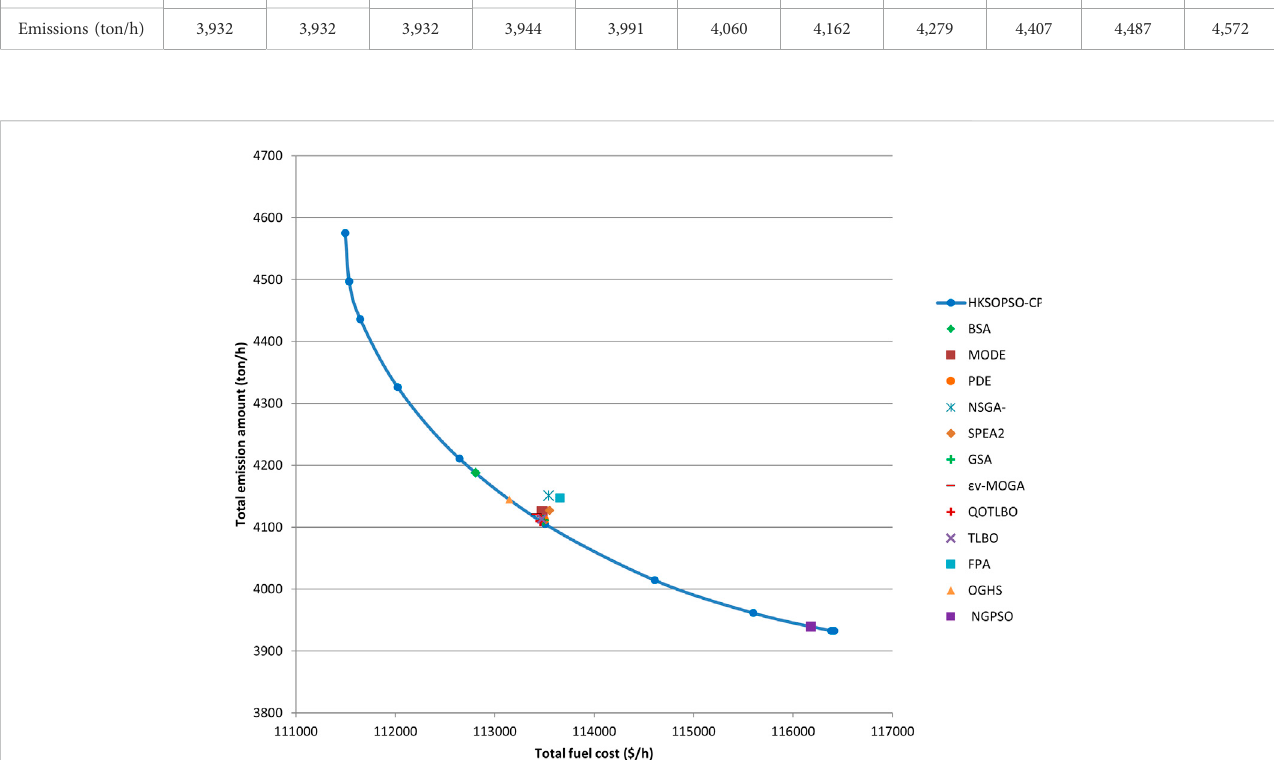
FIGURE 5 Case 2: solutions generated by the HKSOPSO-CP algorithm, and the best compromise solutions provided by other